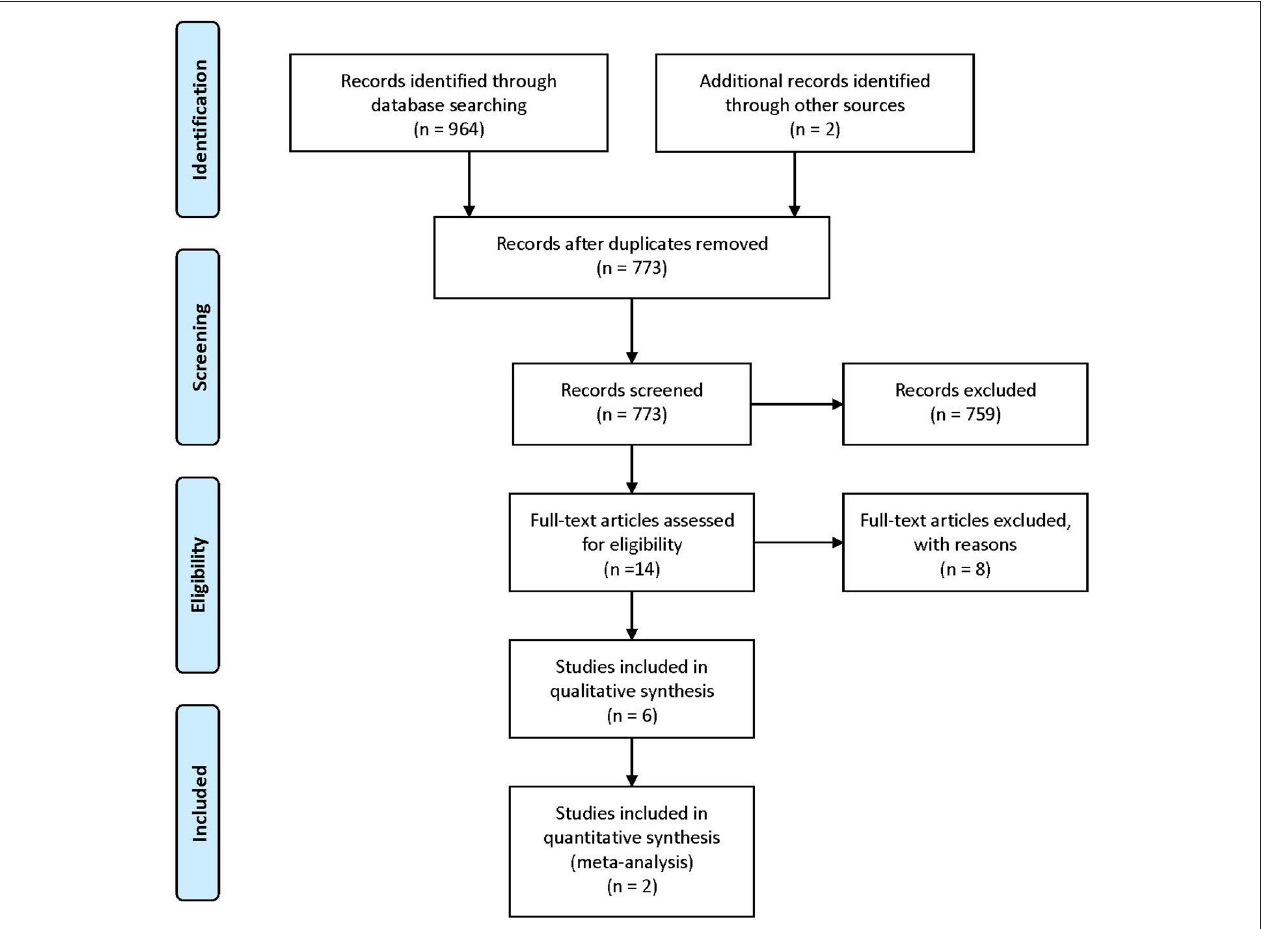
FIGURE 1 | PRISMA diagram of the study selection